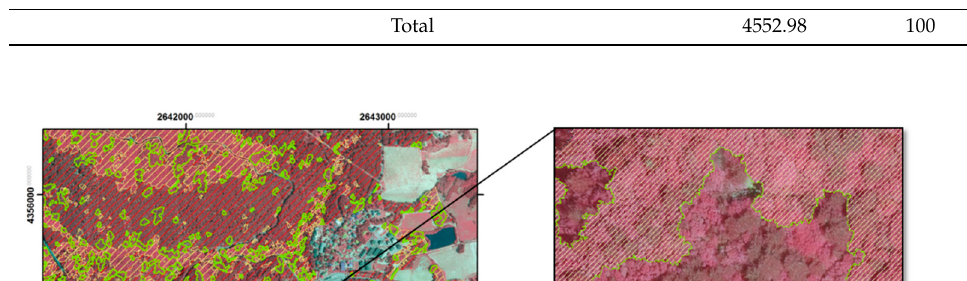
Table 6. Overall accuracy for kNN